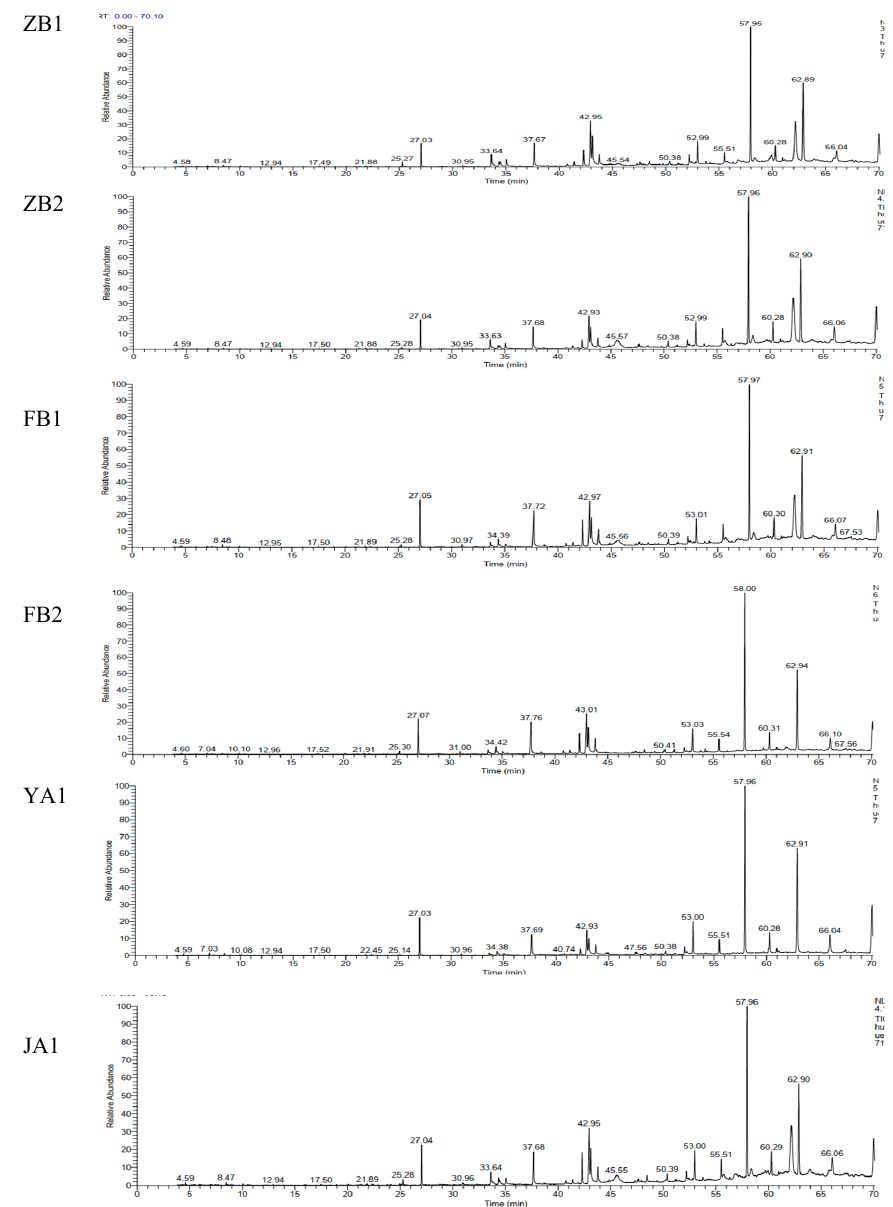
Figure 1. The total ion chromatograms of volatile compounds determined by GC-MS in the D. officinale of ZB1, ZB2, FB1, FB2, YA1 and JA1.